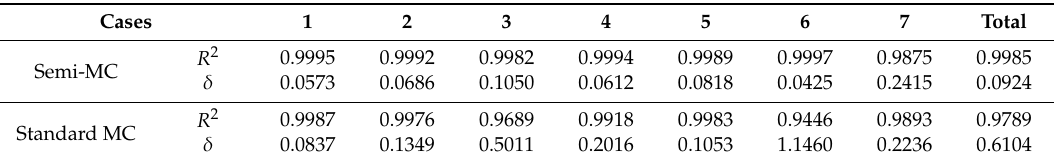
Table 2. The R 2 and δ of the analytical model compared with the semi-analytic and standard MC algorithms according to Figure 2.